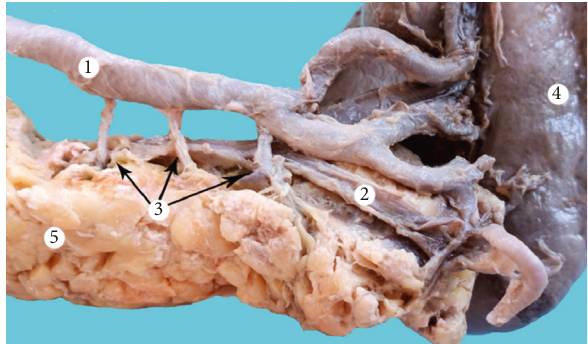
Figure 3: Type I vascular supply of the pancreas (dissection).1: splenic artery; 2: splenic vein; 3: short branches of the splenic artery; 4: spleen; and 5: pancreas.